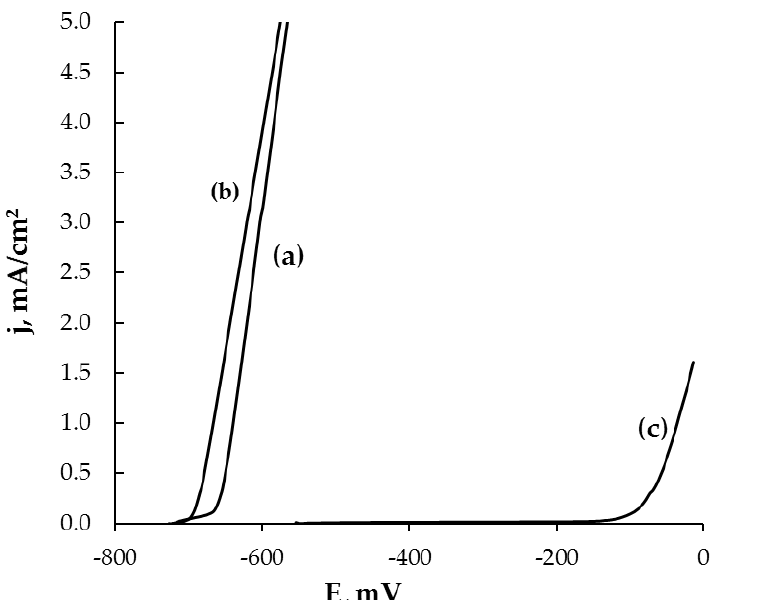
Figure 2. Anode polarization curves of aluminum electrode in solutions: ( a ) 0.5 M NaCl + 0.045 M Zr(NO 3 ) 2 + 0.006 M Ce(NO 3 ) 4 ; ( b ) 0.5 M NaCl + 0.030 Zr(NO 3 ) 2 + 0.050 M Mg(NO 3 ) 2 + 0.006 M Ce(NO 3 ) 4 ; ( c ) 0.1 M NaCl + 0.030 Zr(NO 3 ) 2 + 0.050 M Mg(NO 3 ) 2 + 0.006 M Ce(NO 3 ) 4 .